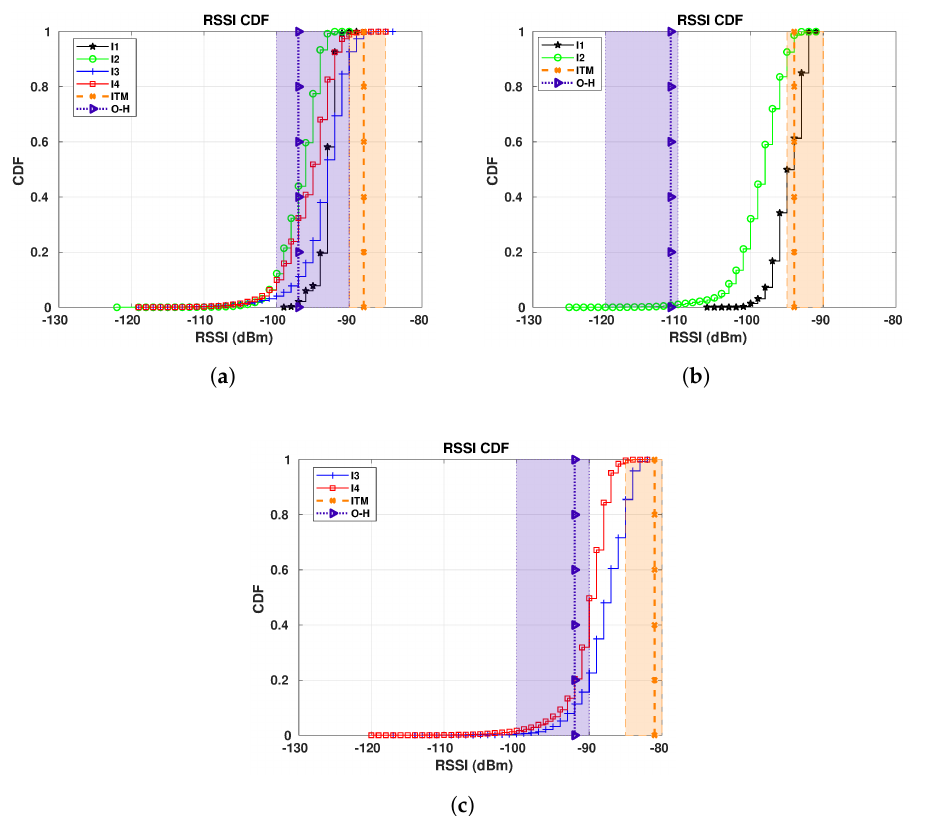
Figure 10. E1 RSSI CDFs for all gateways: I1 (16/01/2019 to 07/02/2019): − 16.96 ◦ C on average; I2 (22/12/2018 to 06/01/2019): − 9.45 ◦ C on average; I3 (25/10/2018 to 04/11/20018): − 0.15 ◦ C on average; I4 (30/09/2018 to 14/10/2018): 6.56 ◦ C on average. ( a ) E1 RSSI CDFs for GW1. ( b ) E1 RSSI CDFs for GW2. ( c ) E1 RSSI CDFs for